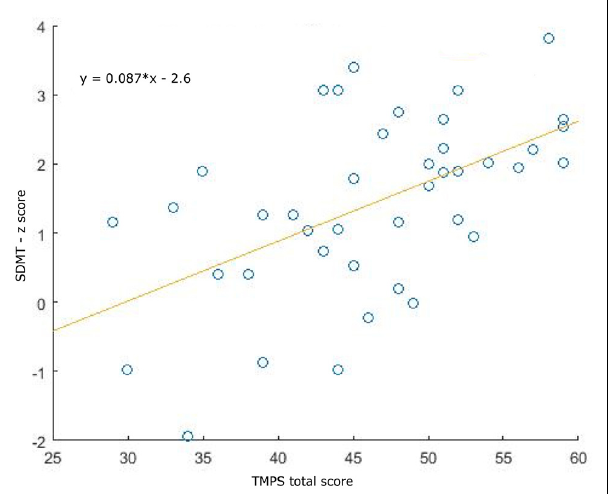
FIGURE 1 | Association plots between Symbol Digit Modalities Test (SDMT) and total Theory of Mind Picture Sequencing Task (TMPS) scores in the multiple sclerosis (MS) patients